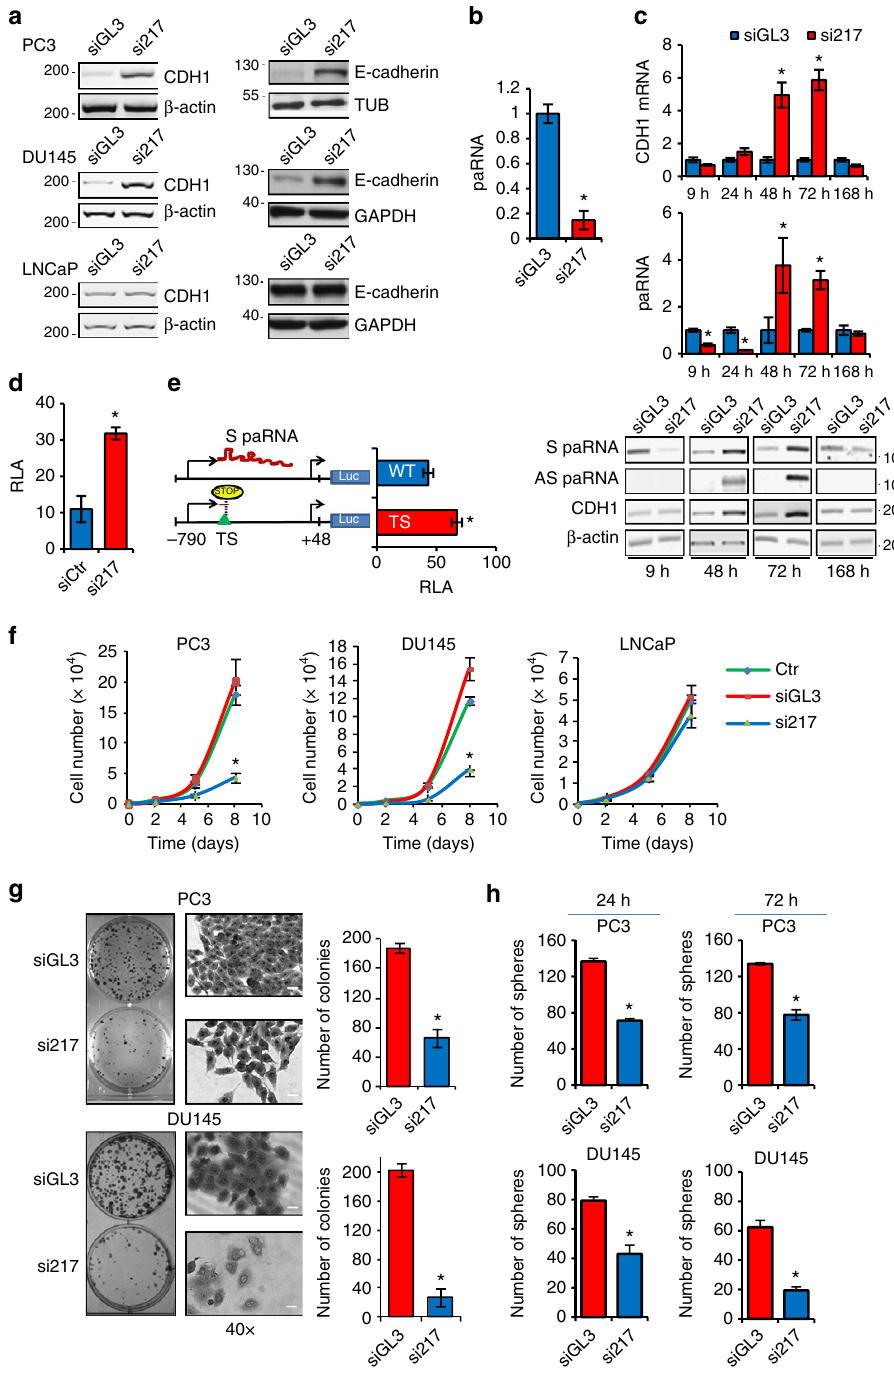
Figure 2 | Promoter-associated RNAs control CDH1 expression. ( a ) Expression of CDH1 mRNA (left) and E-cadherin protein (right) 72h after transfection with si217 or control (siGL3) siRNA. ( b ) paRNA levels in PC3 cells 24h after transfection with siGL3 or si217. ( c ) CDH1 mRNA and paRNAs in PC3 cells after transfection with si217 or siGL3. Top and middle panels, samples analysed by qRT–PCR (CDH1 mRNA and paRNA); lower panel, samples analysed by RT–PCR (CDH1 and b -actin mRNA) or strand-specific RT-PCR (S and AS paRNA). ( d ) Luciferase activity in PC3 cells transfected with CDH1 promoter reporter and either si217 or siGL3. ( e ) Luciferase activity in PC3 cells transfected with CDH1 promoter reporter with either wild-type (WT) sequence or the insertion of a termination site (TS) constituted by the SV40 polyA cassette blocking synthesis of full length S-paRNA (Supplementary Fig. 3f). Left, schematic representation of the WTand TS reporter constructs. ( f ) Proliferation of prostate cancer cells transfected with siGL3, si217 or mock transfected (Ctr). ( g ) Colony formation by PC3 (top panels) and DU145 (bottom panels) cells transfected with si217 or siGL3. Scale bar, 20 m m. ( h ) Tumour sphere formation by PC3 and DU145 cells transfected with si217 or siGL3 and plated after 24 or 72h in stem cell-selective conditions. Data are mean ± s.d. of three independent determinations. Student’s t -test was used for P value assessment. * P o 0.05.